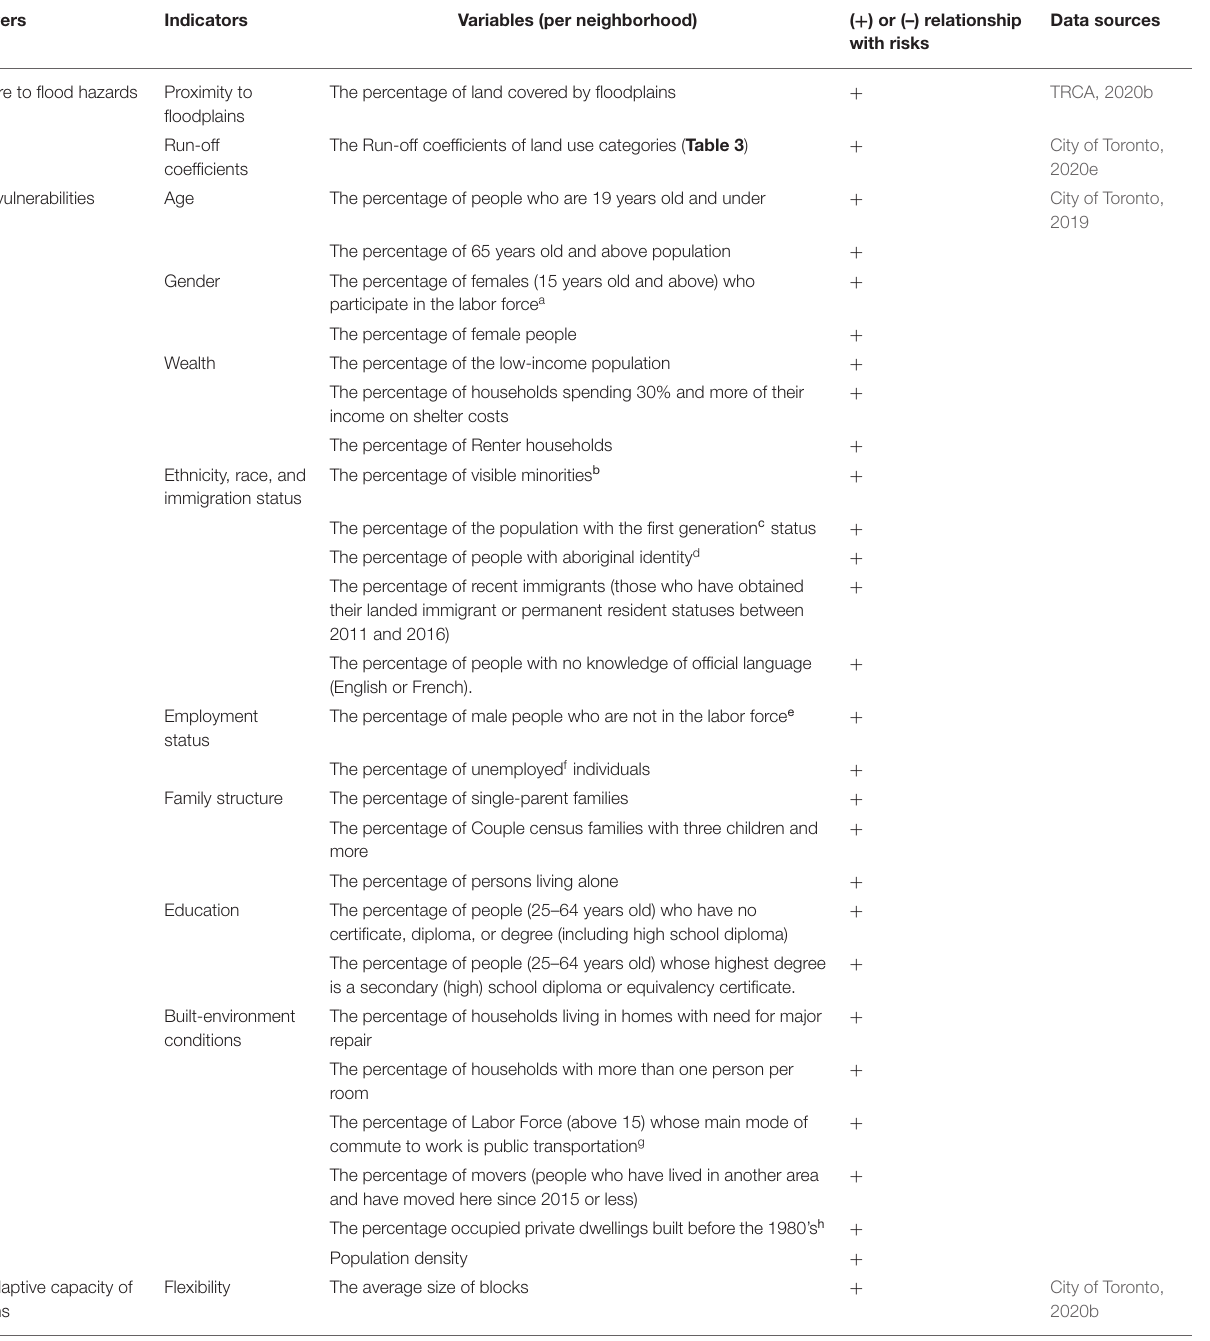
TABLE 2 | The multicriteria model including the major risk drivers and their associated indicators and variables. Risk